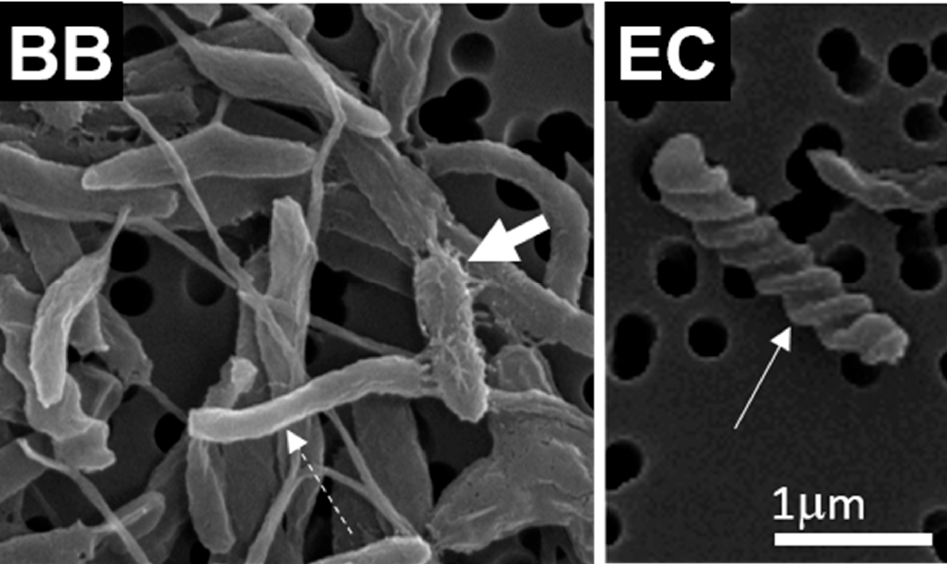
(e.g., Figure 2 EA) in all cultures containing microalgae (EA, BA, EC and BC). Cryo- Figure 2. Scanning electron microscopy images of experimental (left side) and blank (right side) TEM microscopy of an isolate from an axenic microalgal culture showed two types of cultures of axenic microalgae (EA, BA, respectively), co-culture (EC, BC, respectively) and bacteria SCPs: electron-dense clusters and membrane-enclosed EVs (Figure 4F, black and white (EB, BB, respectively). Arrows point to fusiform cells (white arrows), bacteria (dashed white arrows) arrowheads, respectively). The membrane of EVs was surrounded by radially oriented and protrusions on cell surface (fat white arrows). The insets in white rectangles are presented at fibres, forming an approximately 20 nm-thick coat, visible in Cryo-TEM images (Figure 4F). In the isolates from bacterial cultures, we observed singular SCPs and buds having a higher magnification at the right side of the images. smooth globular shape (Figure 4A–D).